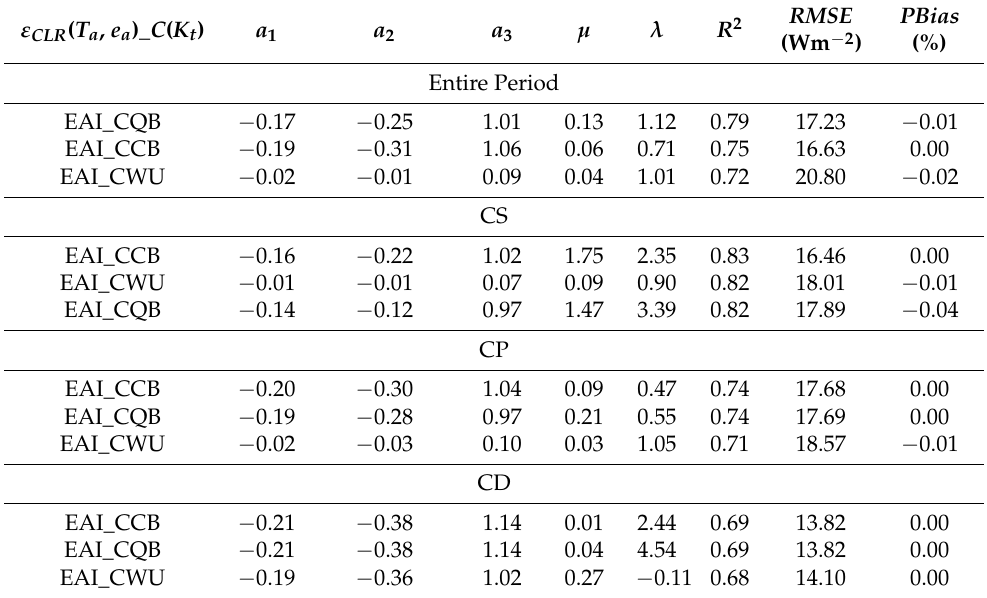
Table 6. Calibrated coefficients and statistical index for the entire period and different sky coverage classifications for EAI in Step